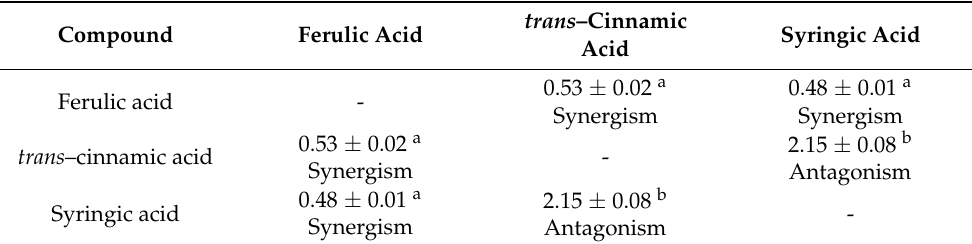
Figure 6. Dose-normalized isobolograms for chosen phenolic acids with lipoxygenase inhibitory activity. ( A ) trans -cinnamic acid and syryngic acid, ( B ) ferulic acid and trans -cinnamic acid, ( C ) ferulic acid and syryngic acid). Table 5. Combination index (CI) value between mixtures consisting of two polyphenols on lipoxygenase LOX activity, n = 9